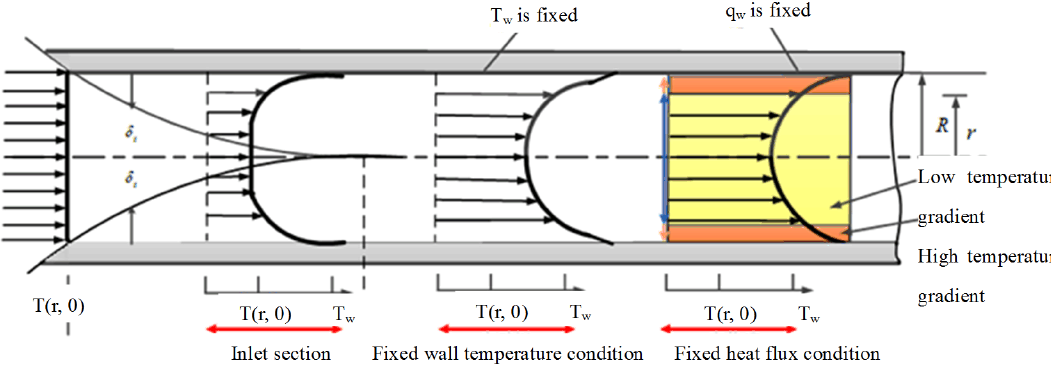
Figure 4. Distribution of internal flow temperature under fixed wall temperature and heat flux